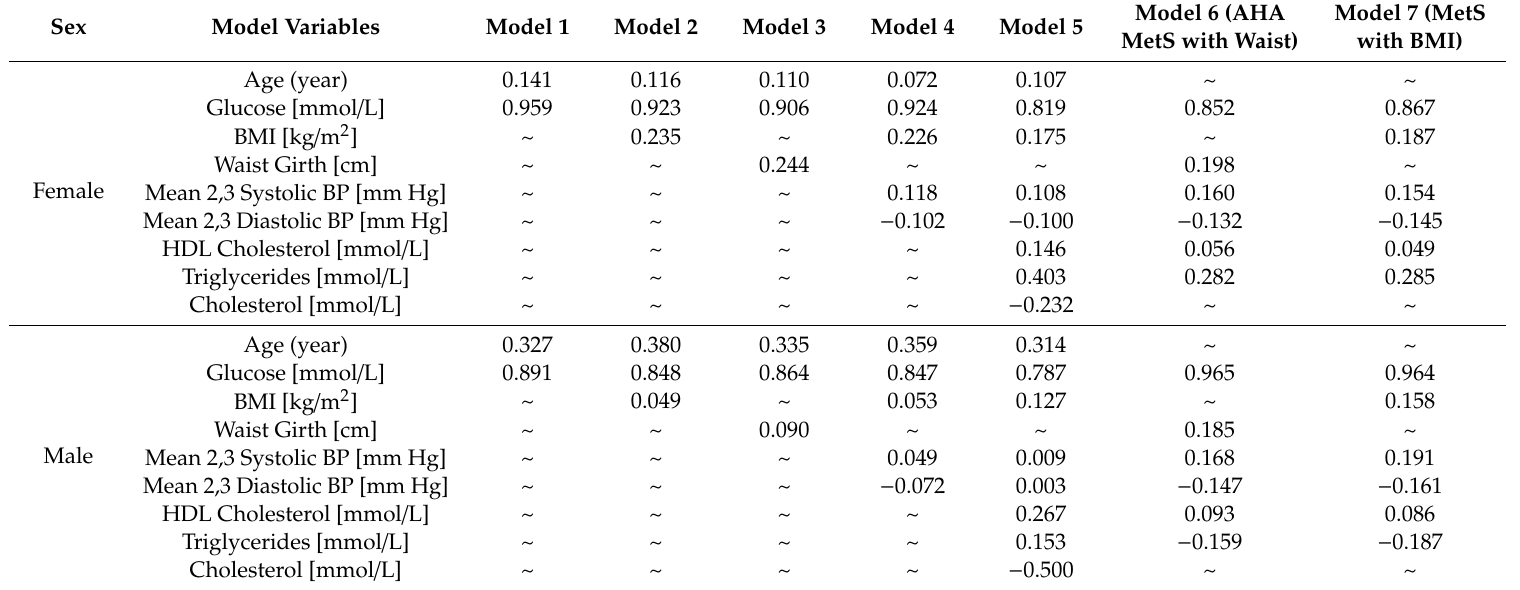
Table 4. Canonical discriminant function coe ffi cients